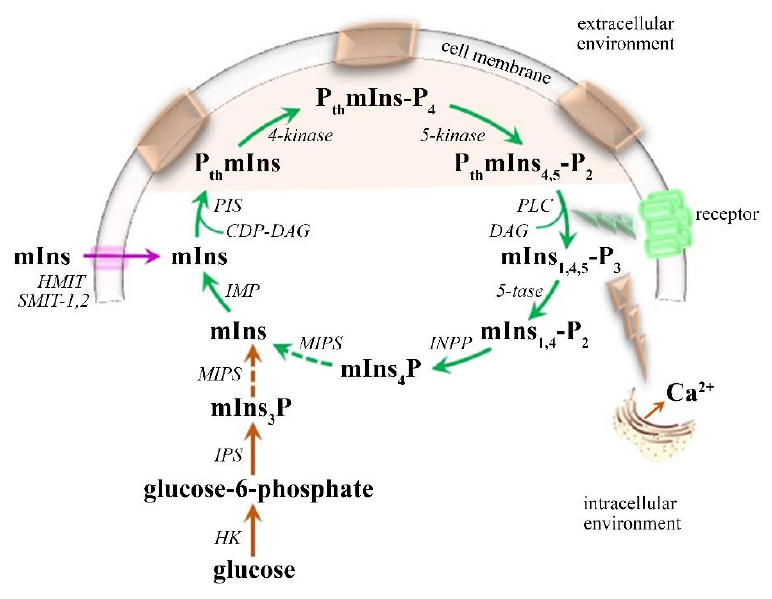
Figure 3. Schematic representation of myoInositol (mIns) metabolism. mIns can be incorporated into cytidine diphosphate diacylglycerol (CDP-DAG) via the activity of phosphatidylinositol synthase (PIS) generating phosphatidylmyoInositol (P th mIns). Further phosphorylation of P th mIns by phosphatidylinositol 4-kinase (4-kinase) forms phosphatidylmyoInositol 4-phosphate (P th mInsP 4 ) and subsequently, via phosphatidylinositol 4-phosphate 5-kinase (5-kinase), produces phosphatidyl 4,5-bisphosphate (P th mIns 4,5 -P 2 ). P th mIns, P th mInsP 4 and P th mIns 4,5 -P 2 are incorporated constituents of cell membranes (depicted as blocks in the cell membrane and colorfully highlighted in the intracellular environment). In response to agonists, activated receptors stimulate phospholipase C (PLC), which hydrolyzes P th mIns 4,5 -P 2 to form DAG and myoInositol 1,4,5-trisphosphate (mIns 1,4,5 -P 3 ). mIns 1,4,5 -P 3 is a soluble molecule capable of binding to membrane receptors on the endoplasmic reticulum causing Ca 2+ release into the cytoplasm. mIns 1,4,5 -P 3 may also be dephosphorylated by inositolpolyphosphate 5-phosphatase (5-tase) forming myoInositol 1,4-bisphosphate (mIns 1,4 -P 2 ) and further by inositol polyphosphate 1-phosphatase (INPP) generating myoInositol 4-monophosphate (mIns 4 P). The activity of several myoInositol phosphate synthases (MIPS) leads to the production of myoInositol 1-monophosphate (mInsP). The dephosphorylation of mInsP to mIns is catalyzed by inositol monophosphatase (IMP). However, mIns can be reuptaken from the extracellular space via three specialized mIns transporters (Na + -dependent myoInositol cotransporters-1 and 2 (SMIT-1,2); H + -dependent myoInositol cotransporter (HMIT)) or synthesized from glucose via hexokinase (HK) and myoInositol-3-phosphate-synthase (IPS) to myoInositol-3-phosphate (mIns 3 P) and further catalyzed by MIPS and IMP.